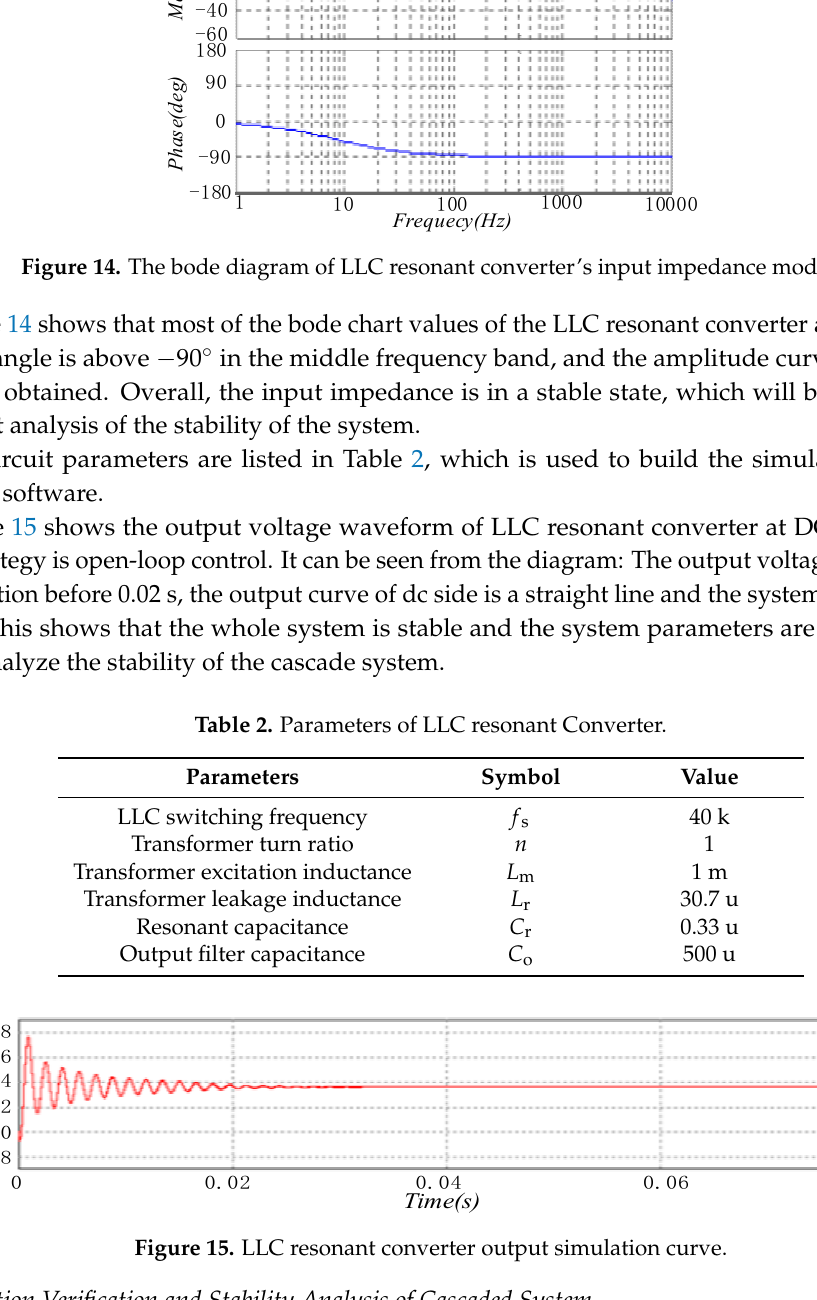
( d ) Figure 16. Output voltage simulation curve of cascade system. ( a ) The three-phase ac side a-phase voltage and current waveform; ( b ) The current curve of the AC side; ( c ) The output voltage waveform of the DC side of the PWM rectifier; ( d ) Output voltage waveform of LLC resonant converter.